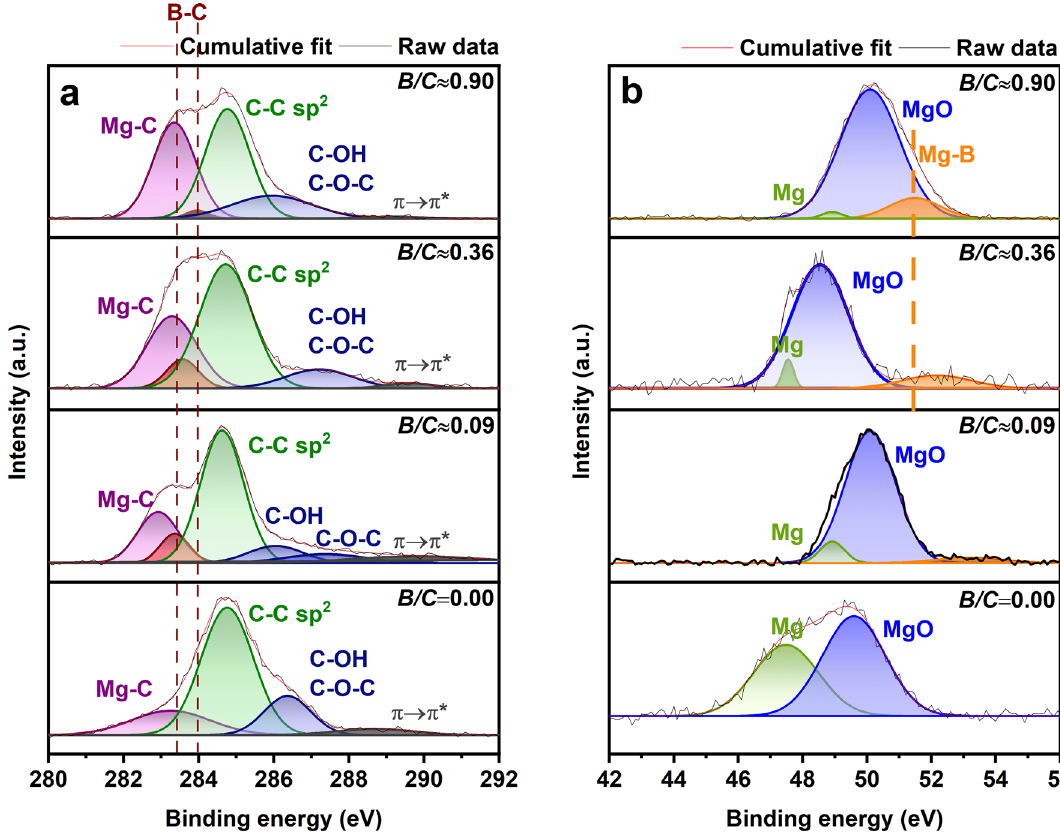
Figure 4. ( a ) C-1s core XPS spectra deconvoluted into Mg-C, B-C, sp 2 hybridized C–C, C–OH, C–O–C and C-2p π → π* transition peaks; ( b ) Mg-2p spectra deconvoluted into metallic Mg, MgO and Mg-B for all the ball milled Mg-B-erGO